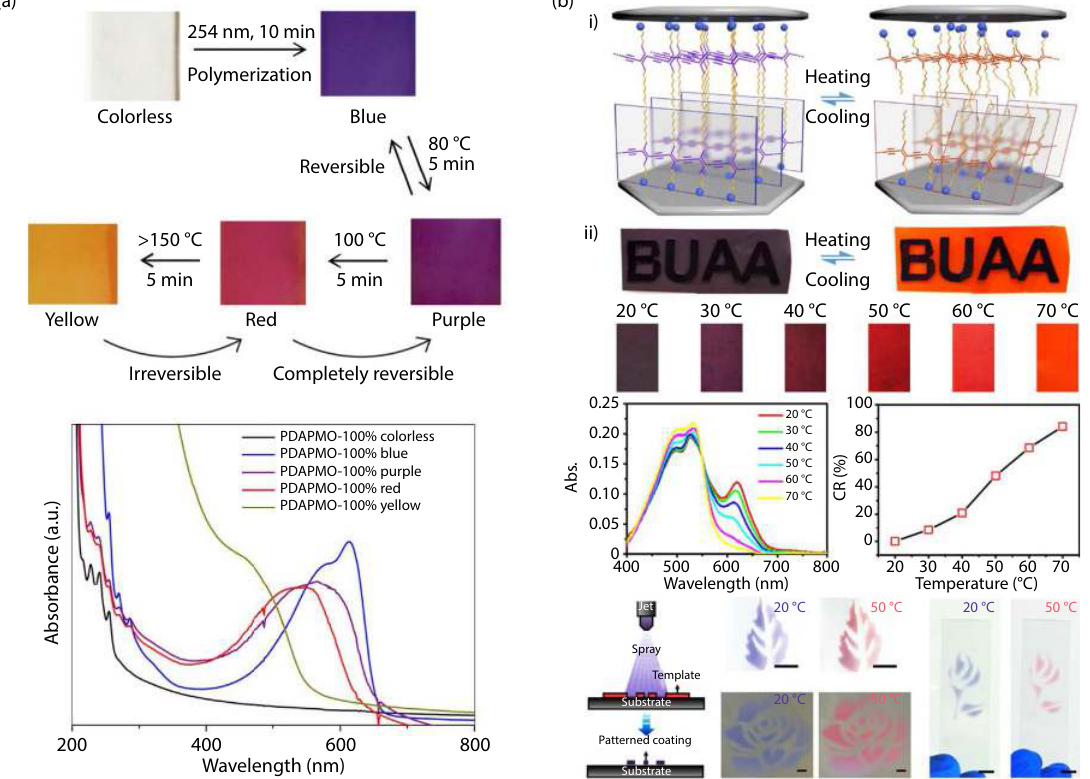
Fig. 11 Thermochromic phenomena of chemosensors based on PDAs. ( a ) Thermochromic behaviours of a type of polydiacetylene-based periodic mesoporous or- ganosilica films (PDAPMO-100%) and their UV–Vis absorption spectra of the colorless, blue, purple, red, and yellow states (reproduced with permission from ref. [173], © 2017 Elsevier). ( b ) Thermochromic artificial nacre based on montmorillonite. (i) Illustration of thermochromism of the artificial nacre. (ii) Reversible ther- mochromism, UV−Vis spectra, and CR values between 20 and 70 °C. (iii) Illustration of the spray coating via a spray gun, and different artificial nacre patterns inkjet- printed on paper, glass slide, and steel plate. All these artificial nacres show reversible thermochromism between 20 and 50 °C. Reproduced with permission from